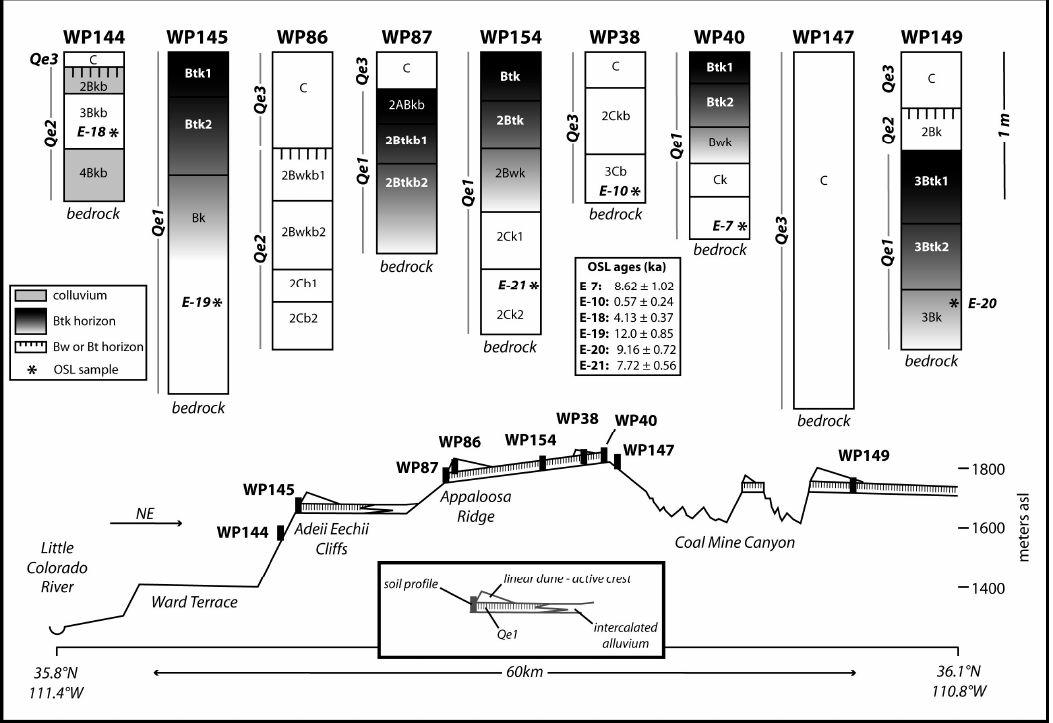
Figure 11. Simplified topographic profile from the Little Colorado River to the northern extent of the Moenkopi Plateau with schematic representation of Qe1 and linear dunes with active crests. Representative soil profiles are shown along the transect with details of soil horizontation, OSL ages, and correlated ages above. WP144 is a climbing dune remnant, WP147 is a falling dune, all other profiles are described in linear dunes or sand sheets. Transect has 100× vertical exaggeration.